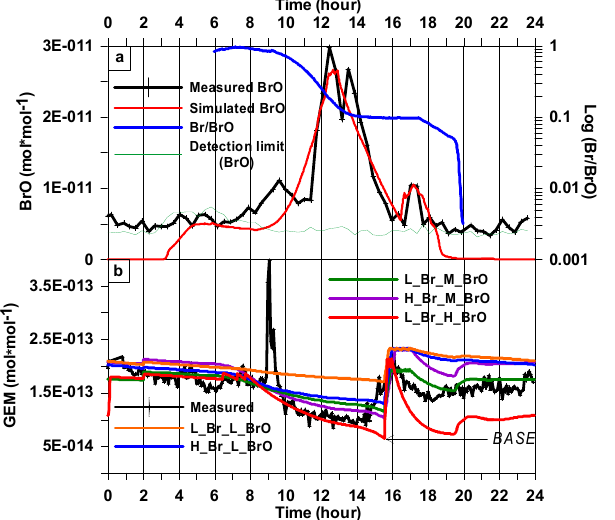
Measured vs. modeled GEM (1:1 line) Fig. 4. Comparison between measured (x-axis) and simulated ratios during midday AMDEs. (y-axis) GEM mixing ratios during midday AMDEs.